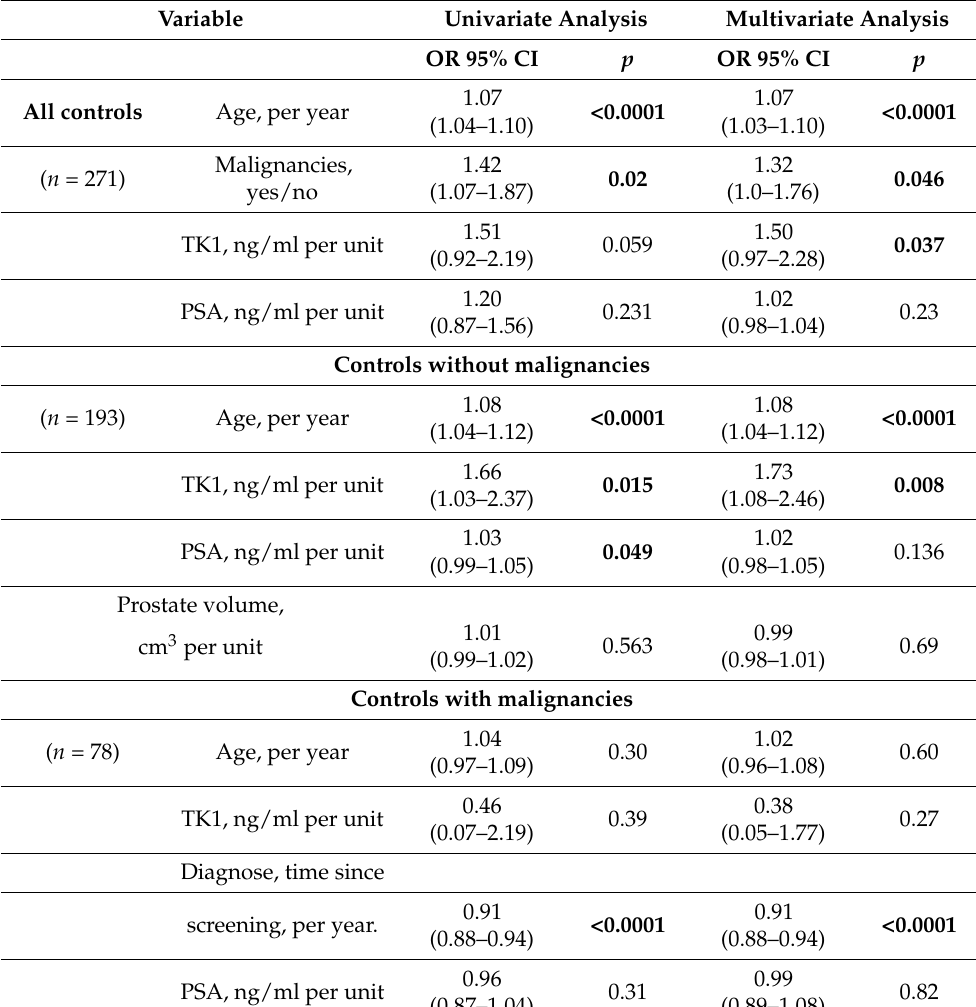
Table 4. Evaluation of baseline data by univariate and multivariate analysis for overall survival in 271 controls without prostate